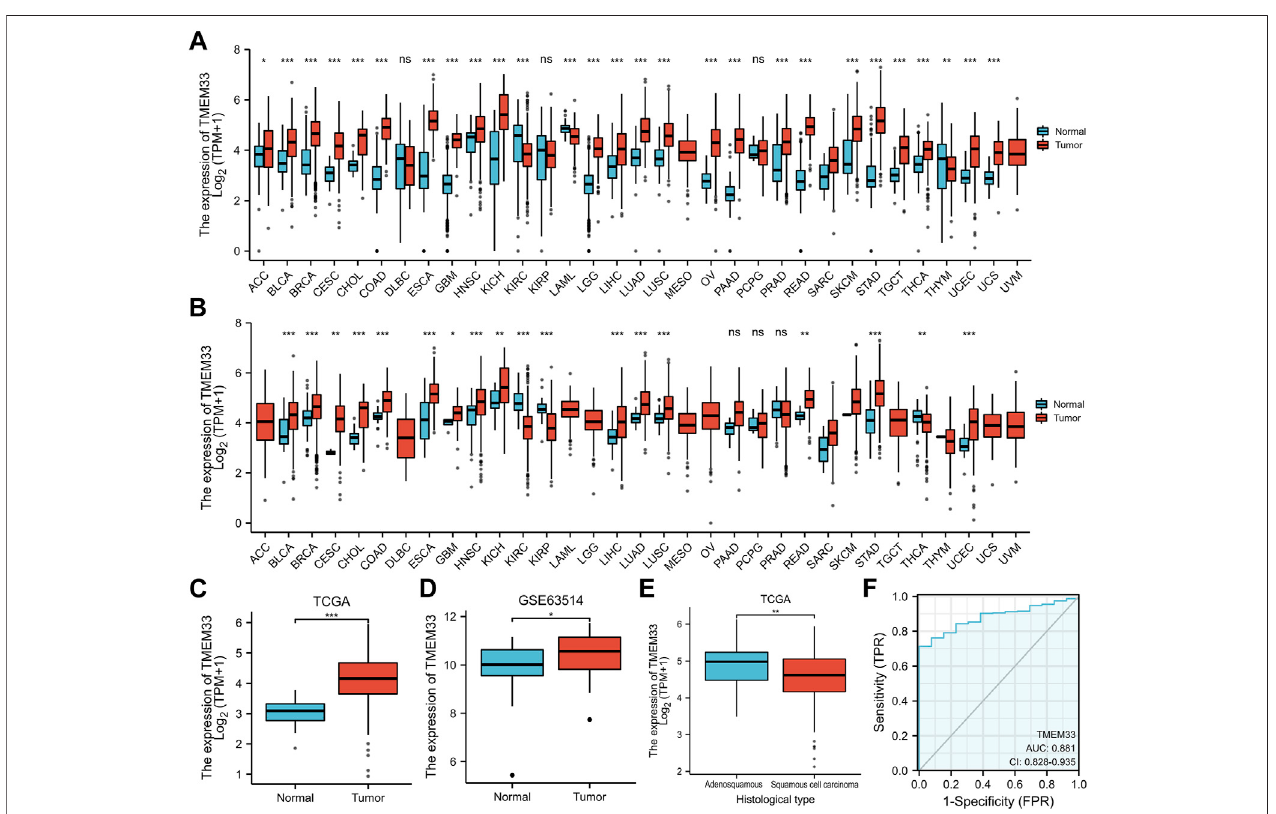
FIGURE 1 | TMEM33 expression in pan-cancers and CESC. Box plots assessing the expression pro fi les of TMEM33 between tumor and normal tissue (A) or between tumor and pericarcinous tissue (B) in different types of cancers based on TCGA and GTEx datasets. (C) The expression of TMEM33 in normal cervical tissue and CESC tissue. (D) The validation of TMEM33 expression in GSE63514 dataset. (E) The expression pro fi le of TMEM33 based on histological type of CESC. (F) Receiver operating characteristic (ROC) curve analysis evaluating the performance of TMEM33 for CESC diagnosis. * p < 0.05, ** p < 0.01, and *** p <